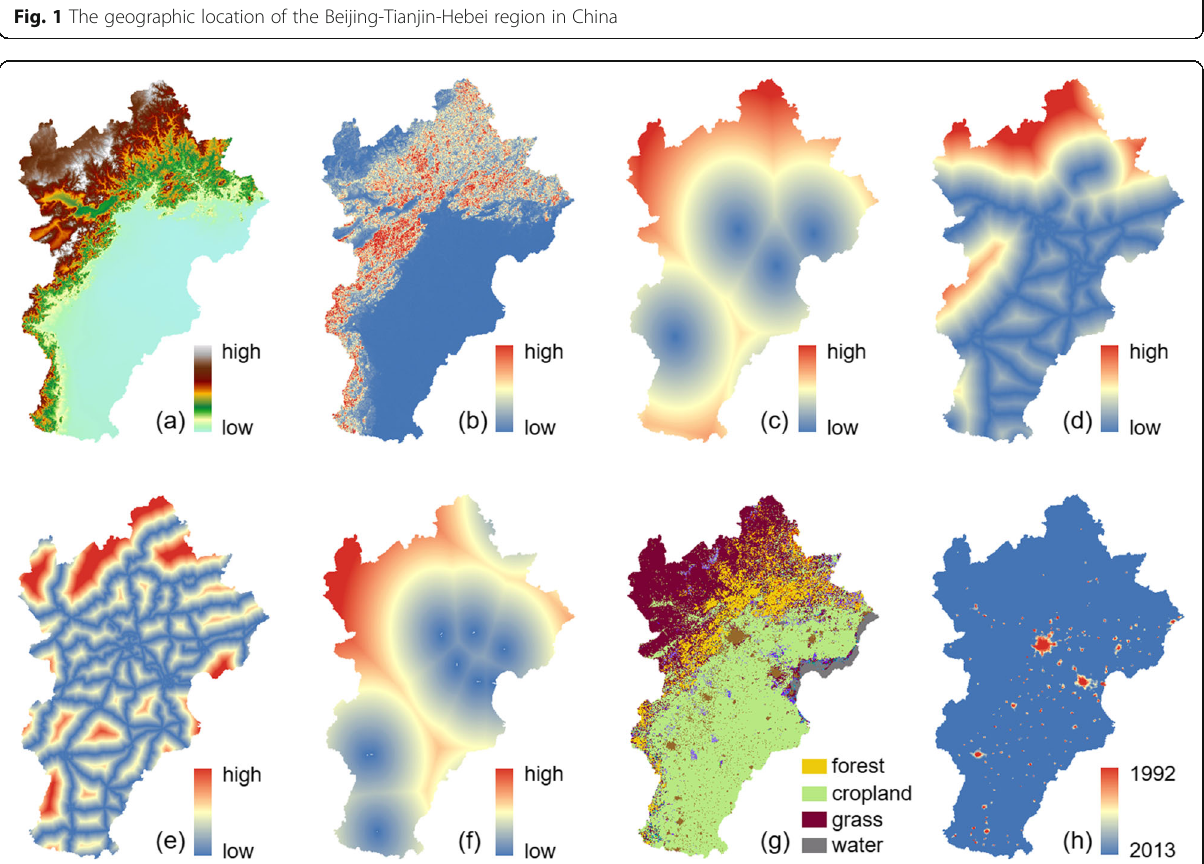
Fig. 2 Spatial proxies and urban extent dynamics in the Beijing-Tianjin-Hebei region. Elevation ( a ), slope ( b ), distance to city centers ( c ), distance to highways ( d ), distance to major roads ( e ), distance to local roads ( f ), land cover ( g ), and urban extent dynamics from NTL observations ( h